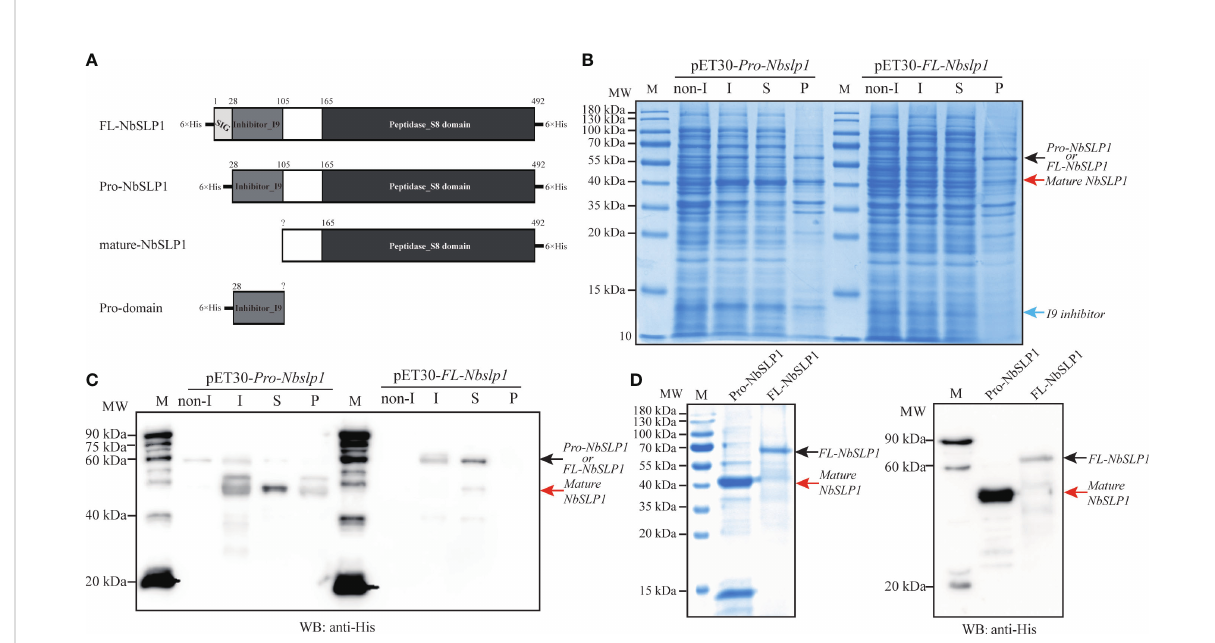
FIGURE 1 Heterologous expression analysis of Pro-NbSLP1 and FL-NbSLP1. (A) Predicted models of full-length NbSLP1 (FL-NbSLP1), signal peptide deleted NbSLP1 (Pro-NbSLP1), mature-NbSLP1 and Pro-domain (Inhibitor_I9 domain), His-tag is showed in thick lines; (B) SDS-PAGE analysis of recombinant expressed Pro-NbSLP1 and FL-NbSLP1 in E . coli BL21 (DE3). Lane M: premixed protein marker (10-180 kDa); (C) Western blot analysis of Pro-NbSLP1 and full-length NbSLP1. (D) : SDS-PAGE and Western blot analysis of puri fi ed protein extracted from E . coli BL21 (DE3) transformed with pET30- pro - Nbslp1 and pET30- FL-Nbslp1. M: ECL marker (20-90 kDa); Full-length NbSLP1 and Pro-NbSLP1 are indicated by black arrows; mature NbSLP1 are indicated by red arrows and Pro-peptide (Inhibitor_I9 domain) is indicated by blue arrow. Primary antibody: anti-His antibody (1:1000 dilution); non I: none induced; I: IPTG induced; S: supernatant after ultrasonication; P: precipitate after